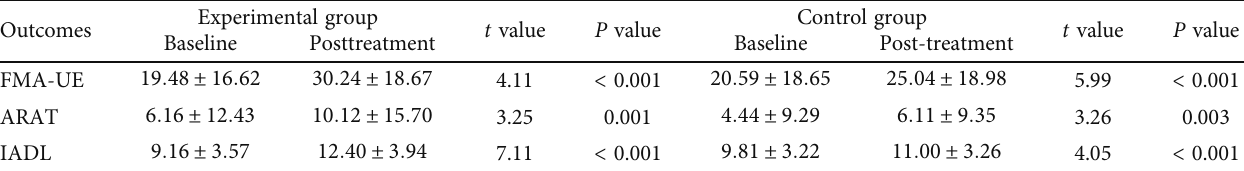
Table 2: The scores of FMA-UE, ARAT, and IADL at baseline and posttreatment in two groups.